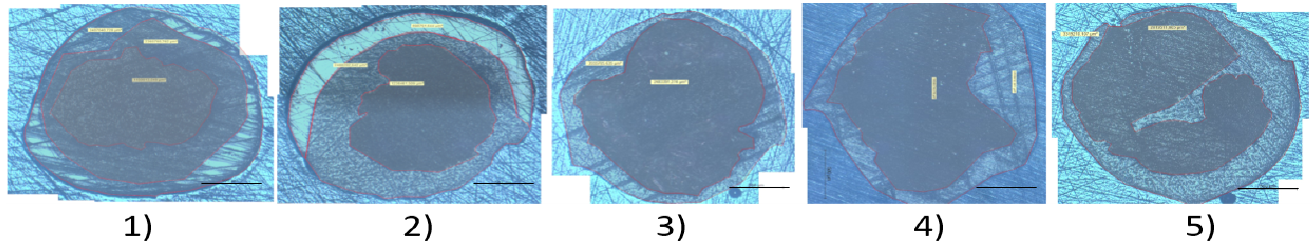
Figure 9. Microscopic reconstruction view of sample numbers 1 to 5. Contoured regions represent the filament area. Scale represents 500 µ